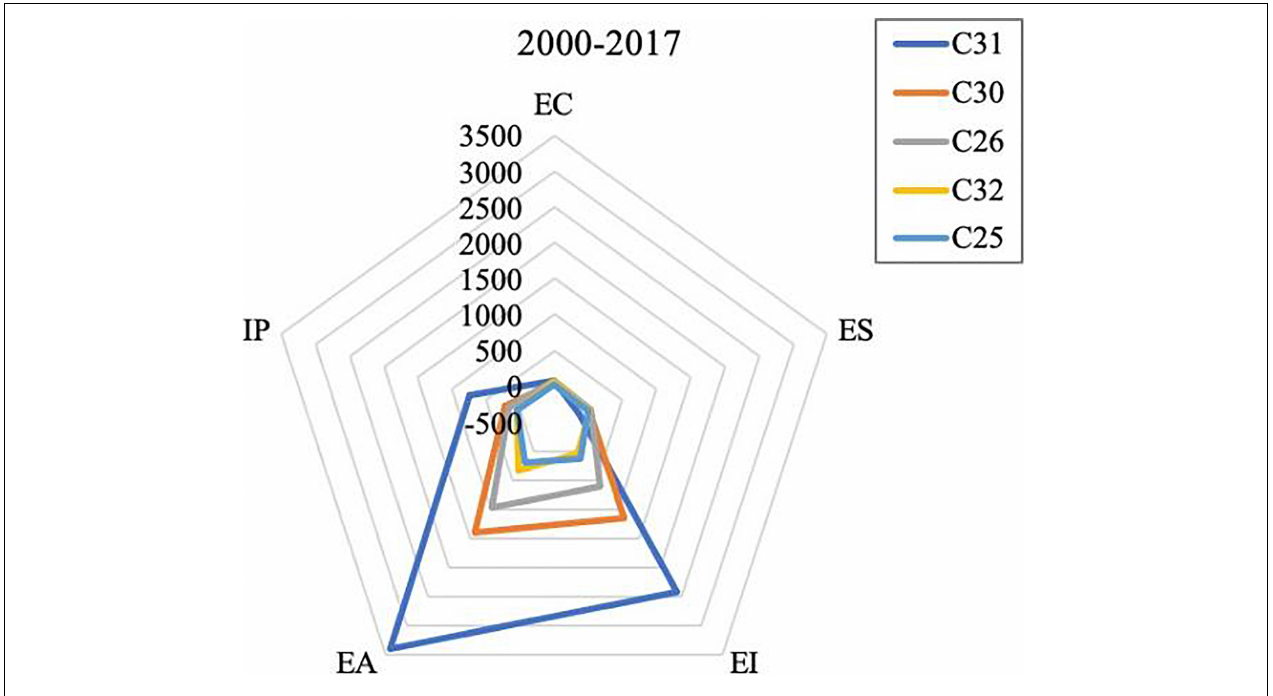
FIGURE 3 | Decomposition result of carbon emission changes in sub-industry. TABLE 1 | Potential of Carbon Emission Reduction of Smart Grid in